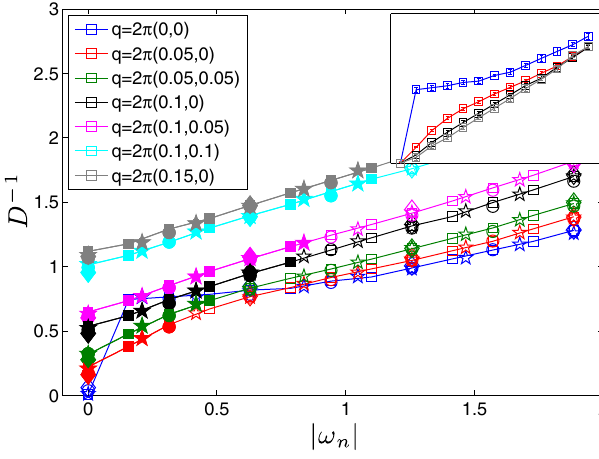
FIG. 12. Frequency dependence of the inverse nematic corre- lator at h ≈ h for a variety of small momenta q in an L ¼ 20 c system at temperatures T ¼ 0 . 025 , 0.033, 0.05, 0.1 (shown as squares, stars, circles, and diamonds, respectively). Different colors represent different values of q , and filled symbols mark q j , where v < v frequencies j ω is the minimum value of the n j F j F bare Fermi velocity. The frequency dependence is essentially linear except at the few smallest frequencies and momenta. The inset shows the subset of the data with T ¼ 0 . 025 and momenta along the (10) direction shifted by their zero-frequency value, with the same scale as the main